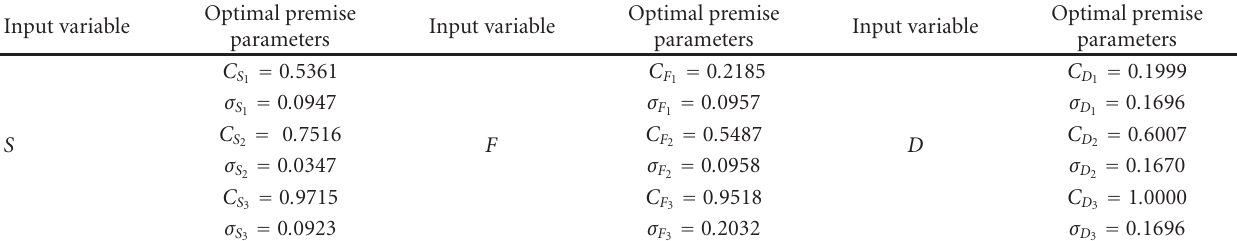
Table 8: The optimal premise parameters of ANFIS FO Sugeno model trained with HL algorithm.